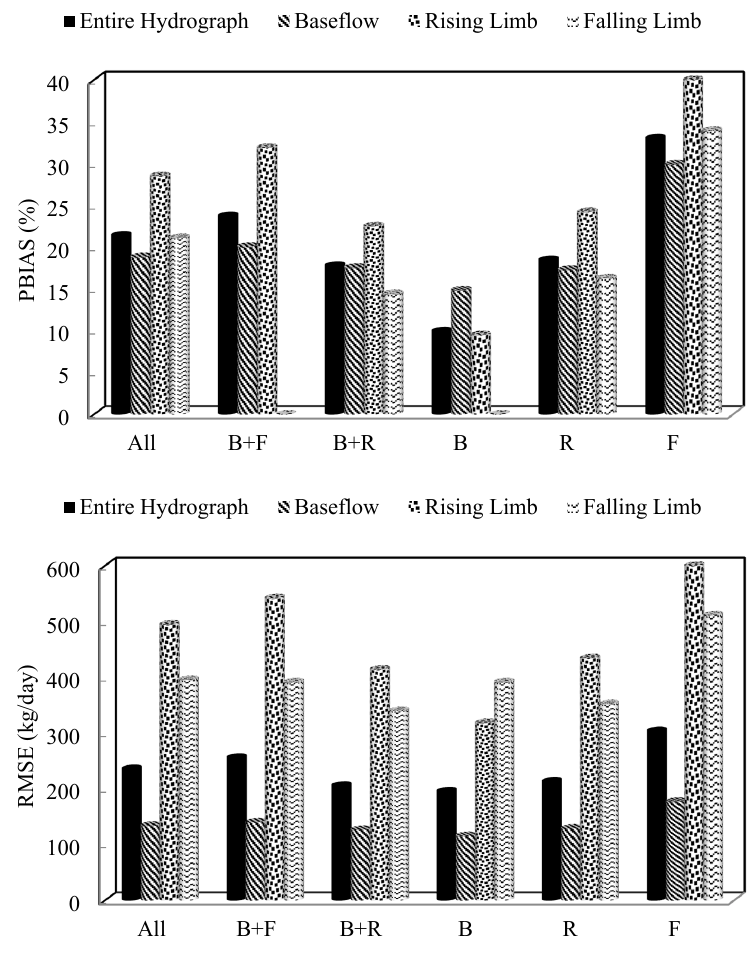
Figure 7. Validation of LOADEST regression models at different stages of the hydrograph. On the x axis, “All” represents the regression model built by using all USGS grab samples. Subsequently B, R, and F denote “Baseflow”, “Rising”, and “Falling” models. B + F and B + R denote “Baseflow + Rising” and “Baseflow + Falling” models.